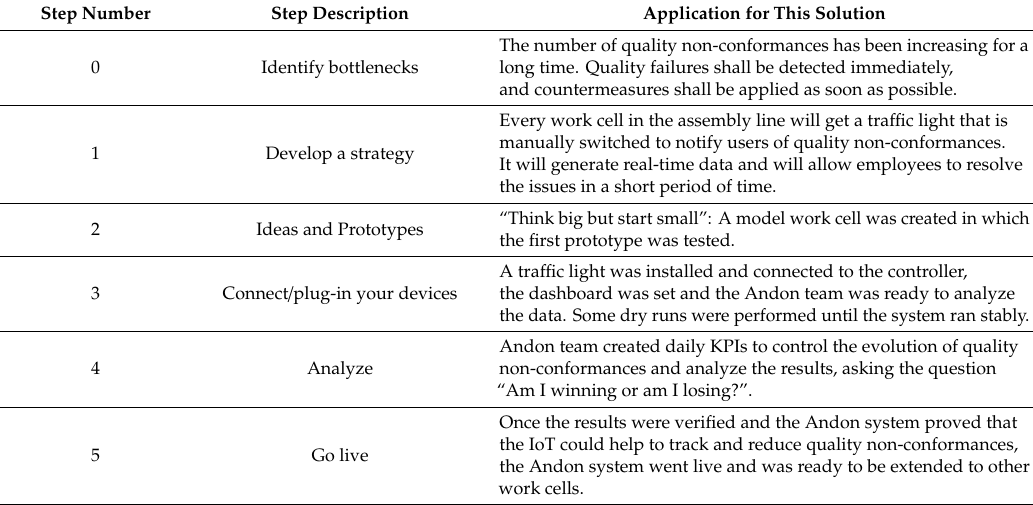
Table 3. Andon system—roadmap